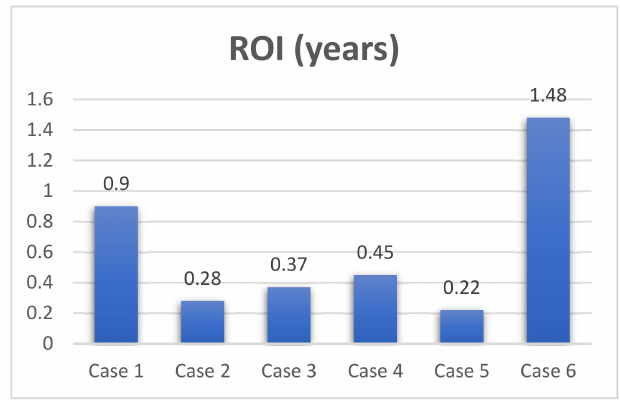
Figure 4. Comparison of ROI for the six cases when using the electric brake regenerative technique.